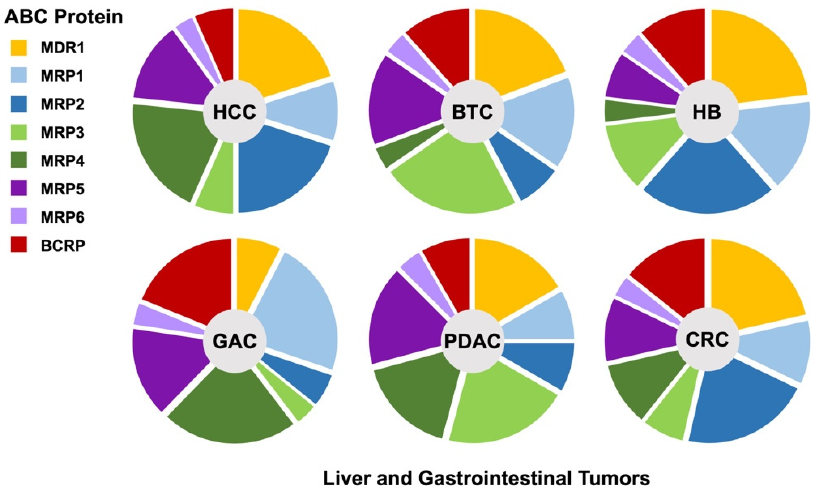
Figure 1. Expression pattern of ABC proteins involved in chemoresistance of liver and gastrointestinal cancers. HCC, hepatocellular carcinoma; BTC, biliary tract cancer; HB, hepatoblastoma; GAC, gastric adenocarcinoma; PDAC, pancreatic ductal adenocarcinoma; CRC, colorectal carcinoma.